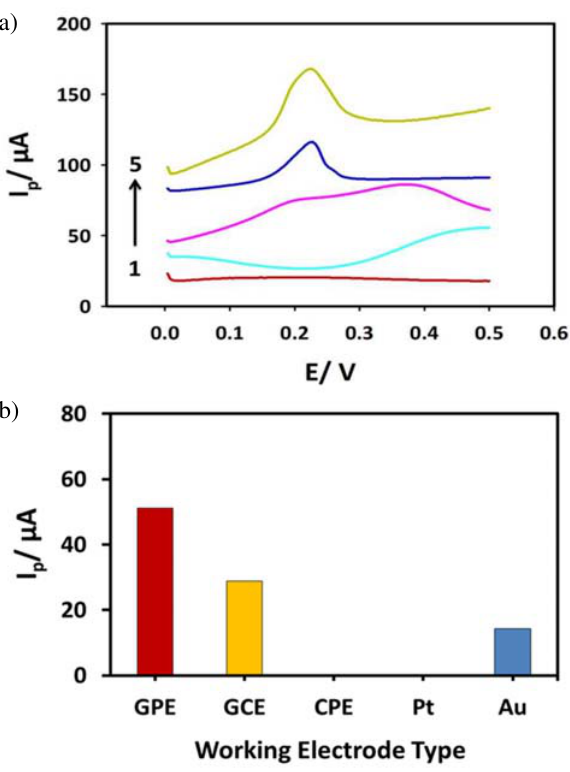
Figure 2: a) Square wave anodic stripping voltammograms (SWASVs) and b) corresponding histograms of 6.2 × 10 –7 mol/L Hg(II) in acetate buffer (0.1 mol/L, pH 5.5) at 1) unpretreated (6) and pretreated GPEs in 1) NaOH, 2) LiClO